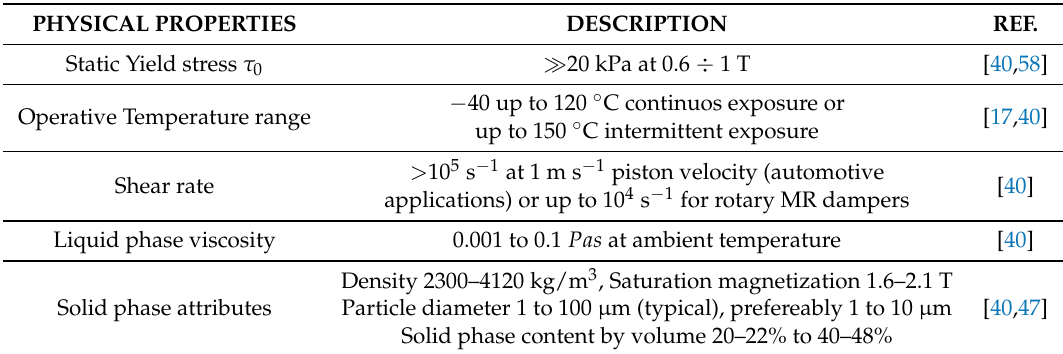
Table 3. MR fluids typical